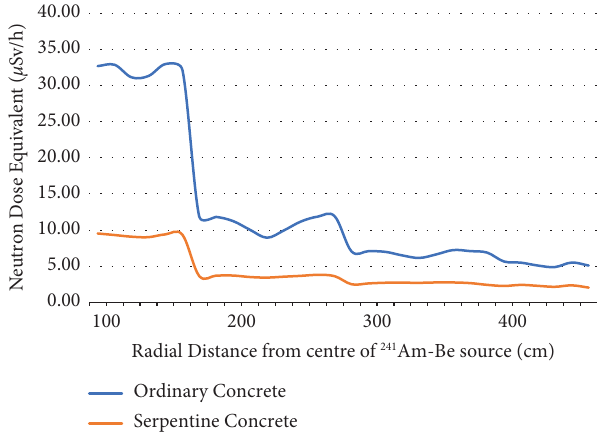
Figure 5: Graph of neutron dose equivalent versus radial distance from the centre of 241 Am-Be source.